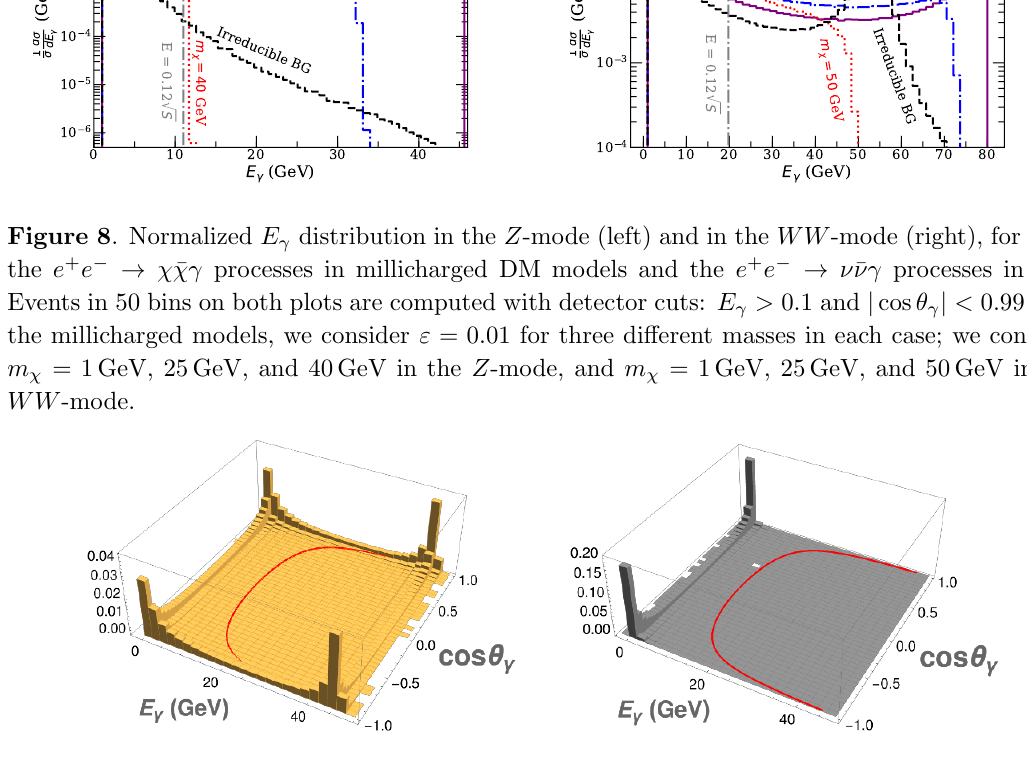
Figure 9 . Monophoton distributions in the E (cid:13) -cos (cid:18) (cid:13) plane in millicharged DM models (left) and in SM irreducible background (right). Events on both plots are computed in the CEPC Z -mode. For the millicharged model, we use m (cid:31) = 1 GeV and " = 0 : 01. The red curves on both plots indicate E m ( (cid:18) (cid:13) ) as given in eq. B